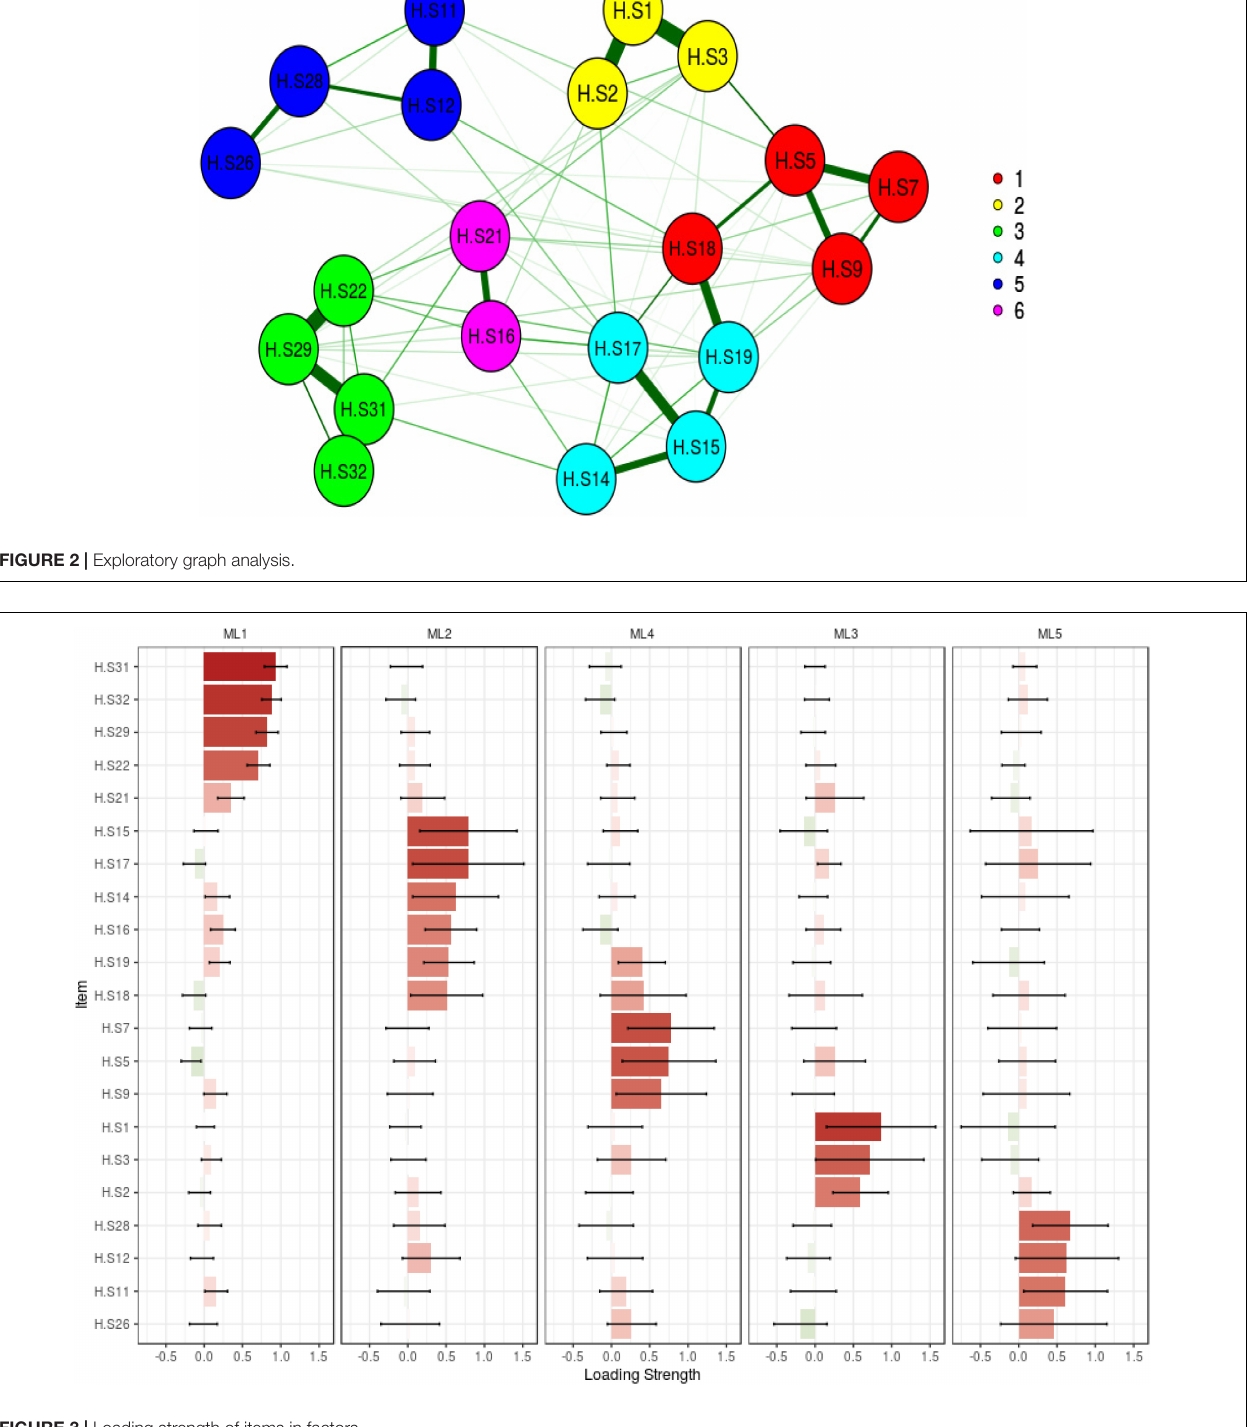
FIGURE 3 | Loading strength of items in